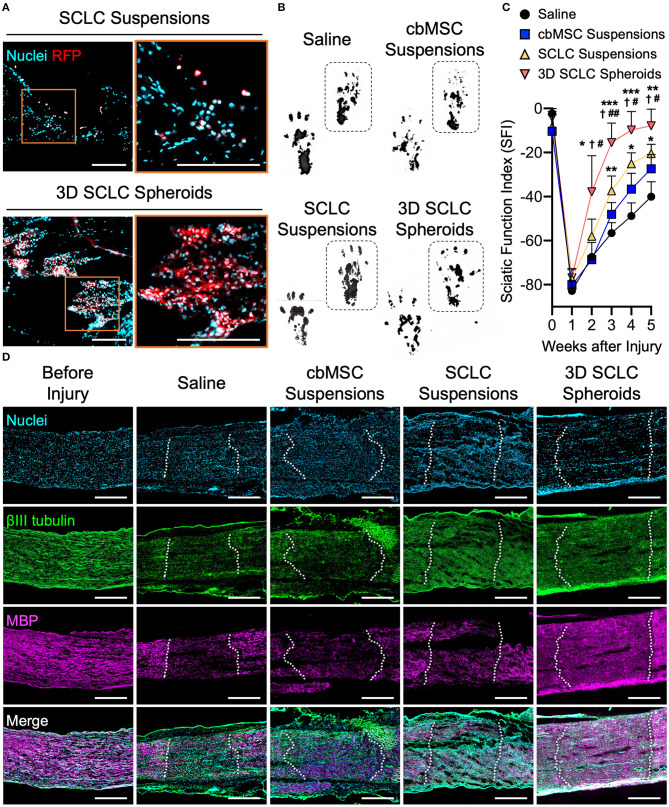
3D SCLC spheroids were transplanted into crush-injured rat sciatic nerves to promote regeneration. (A) Representative fluorescent images showing the retention of transplanted cells labeled with red fluorescence protein (RFP) in sciatic nerve tissues at 1 h postoperation. Orange box is enlarged in right panel. Scale bars: 200 μm. (B) Representative hind feet tracks of mice recorded 4 weeks after cell transplantation and (C) the corresponding sciatic function index (SFI). The dashed boxes highlight the prints of the experimental feet (n = 3, mean ± s.d.). *P < 0.05 vs. saline group; **P < 0.01 vs. saline group; ***P < 0.005 vs. saline group; P < 0.05 vs. cbMSC-suspension group; #P < 0.05 vs. SCLC-suspension group; ##P < 0.01 vs. SCLC-suspension group. (D) Expression of βIII tubulin and myelin basic protein (MBP) determined by immunofluorescence staining. The dotted lines indicate the borders of injury sites. Scale bars: 500 μm.